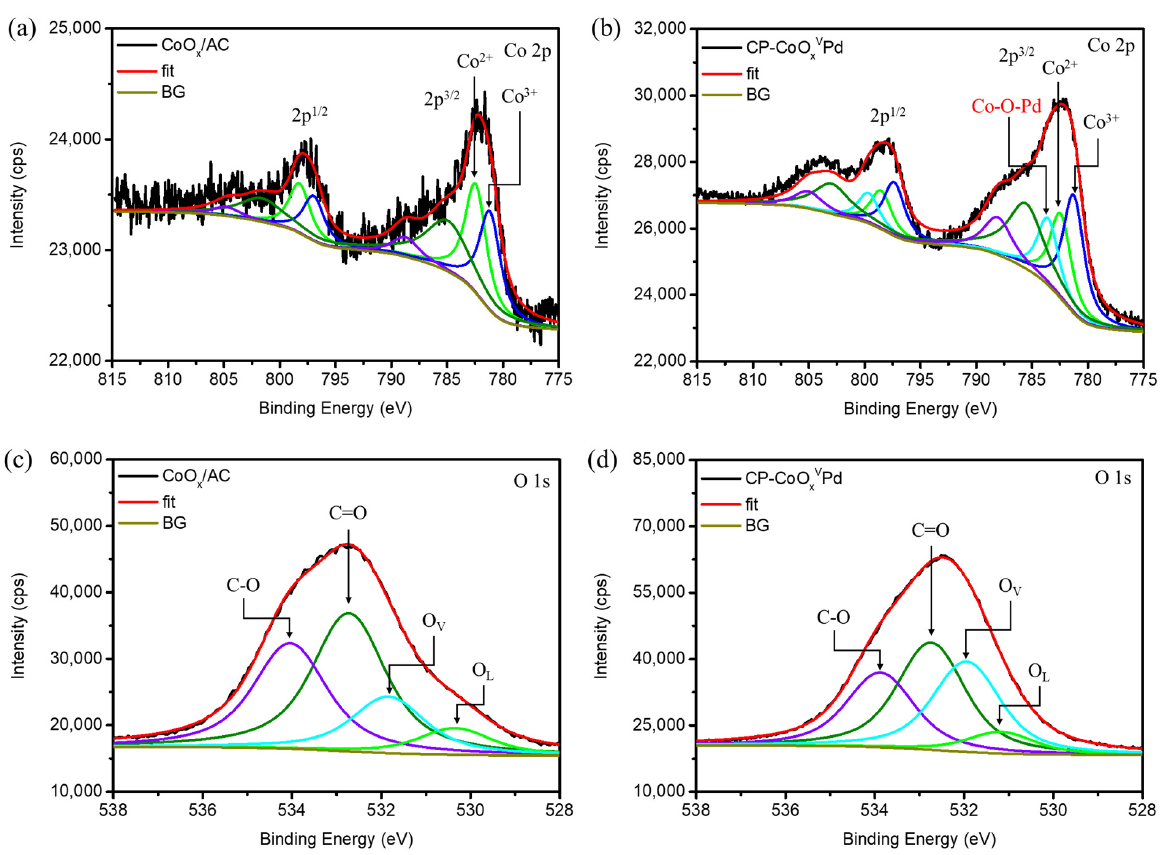
Figure 4. X-ray photoelectron spectroscopy of ( a ) CoO x /AC and ( b ) CP-CoO xV Pd NCs at Co-2p orbital. ( c ) CoO x /AC and ( d ) CP-CoO xV Pd NCs at O-1s orbital.